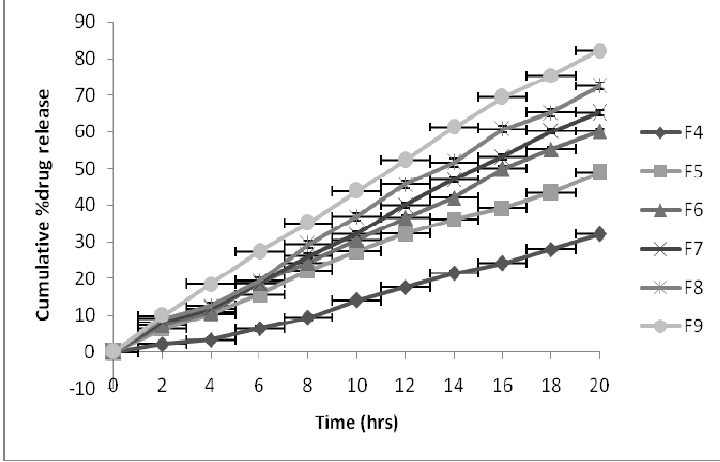
Figure 2. Dissolution of carvedilol from asymmetric membrane capsules.